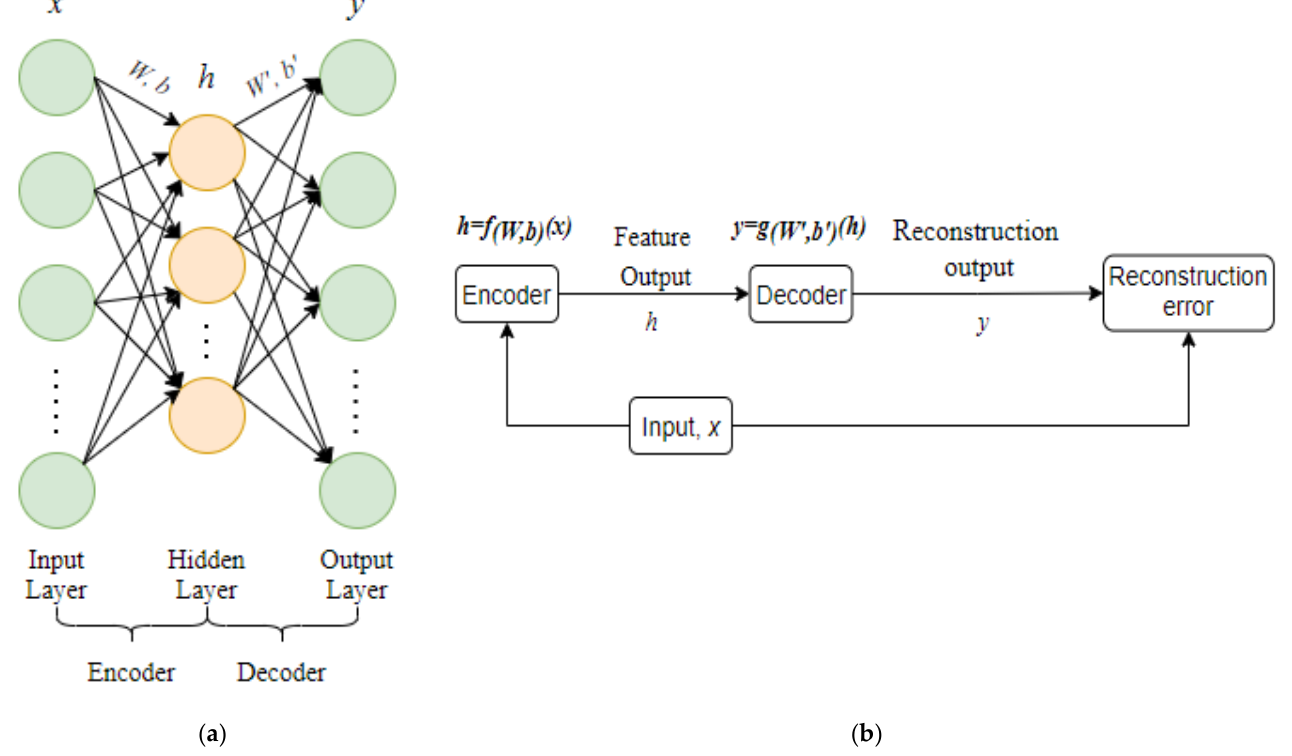
Figure 4. Structure of autoencoding (AE) process: ( a ) basic layout of the self-encoding network; ( b ) workflow of the self-encoding network.